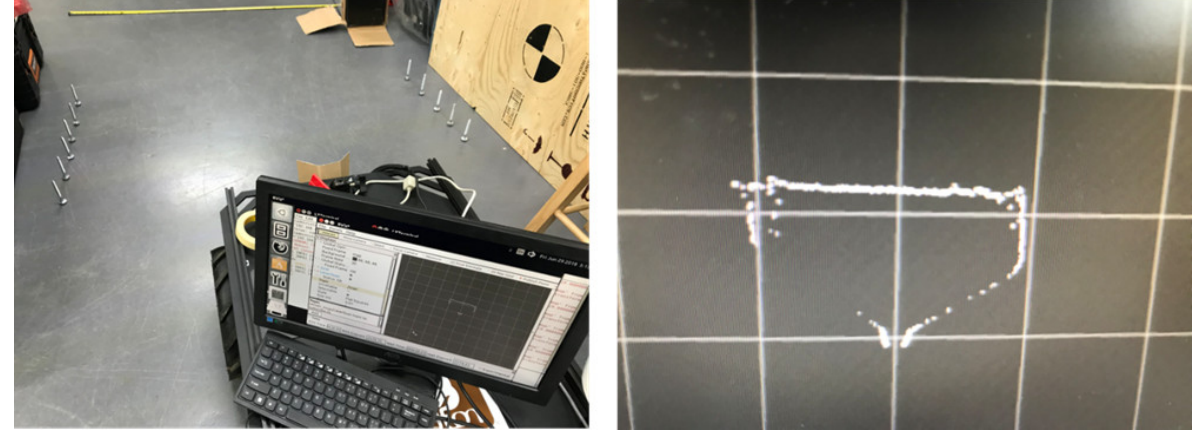
Figure 14. Simulated plant rows using bolts.